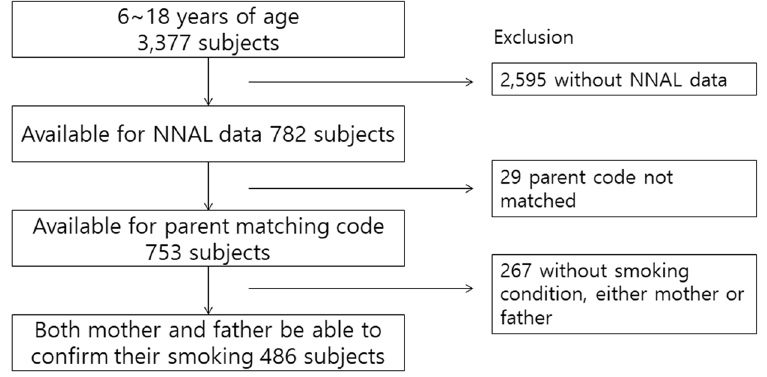
Figure 1. Flow chart of study participants included in this study.